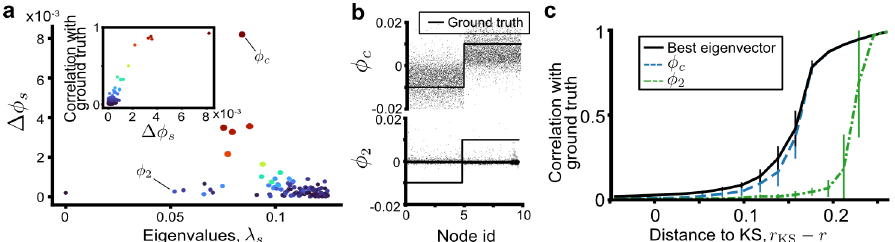
Fig. 3 Detecting communities using pairs of diffusions near the weak recovery limit. a Difference in eigenvectors Δ ϕ s (Eq. (8)) between diffusion processes started at adjacent nodes for a single sparse SBM network ( p in = 3/ n , p out = 0.5/ n , n = 10 4 ). Each dot marks ( λ s , Δ ϕ s ) for the 50 smallest eigenvectors, coloured by the correlation of the corresponding eigenvector with the ground truth, shown in the inset. b The eigenvector ϕ c with the highest Δ ϕ ϕ s encodes the cluster structure (solid line), whereas the second eigenvector 2 , used by spectral clustering methods, are driven by high random fl uctuations. c Correlation of eigenvectors with ground truth against distance to KS limit ( n = 10 5 , (cid:2) k ¼ 3). The eigenvector identi fi ed by the highest Δ ϕ s approaches the correlation with the ground truth of the best eigenvector in the spectrum. All eigenvectors become uncorrelated with the ground truth at the KS limit. Error bars indicate one standard deviation from the